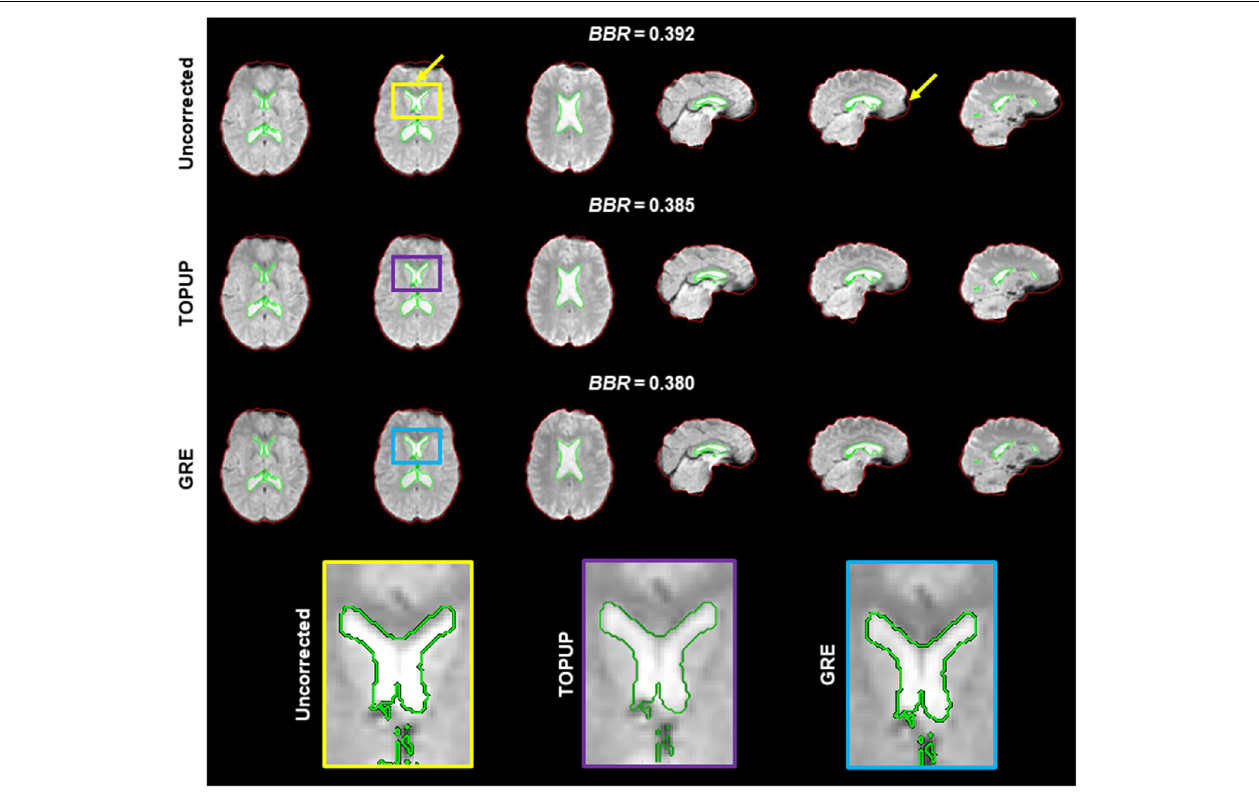
FIGURE 5 | Registration into the structural image of (top) uncorrected, (middle) TOPUP corrected, and (bottom) GRE corrected fMRI data of the first participant illustrated in Figure 2 . The red and green traces define the contours of the brain-extracted structural image and its segmented ventricles (I and II), respectively; these can be considered as the ground truth. Besides the squashed voxels in areas of tissue/air boundaries (right yellow arrow), it is clear that the registration of uncorrected data fails to capture the spatial distribution of the ventricles I and II (left yellow arrow); a critical region in ventricle I is zoomed in the yellow, purple and blue boxes. The BBR cost function values are also shown.